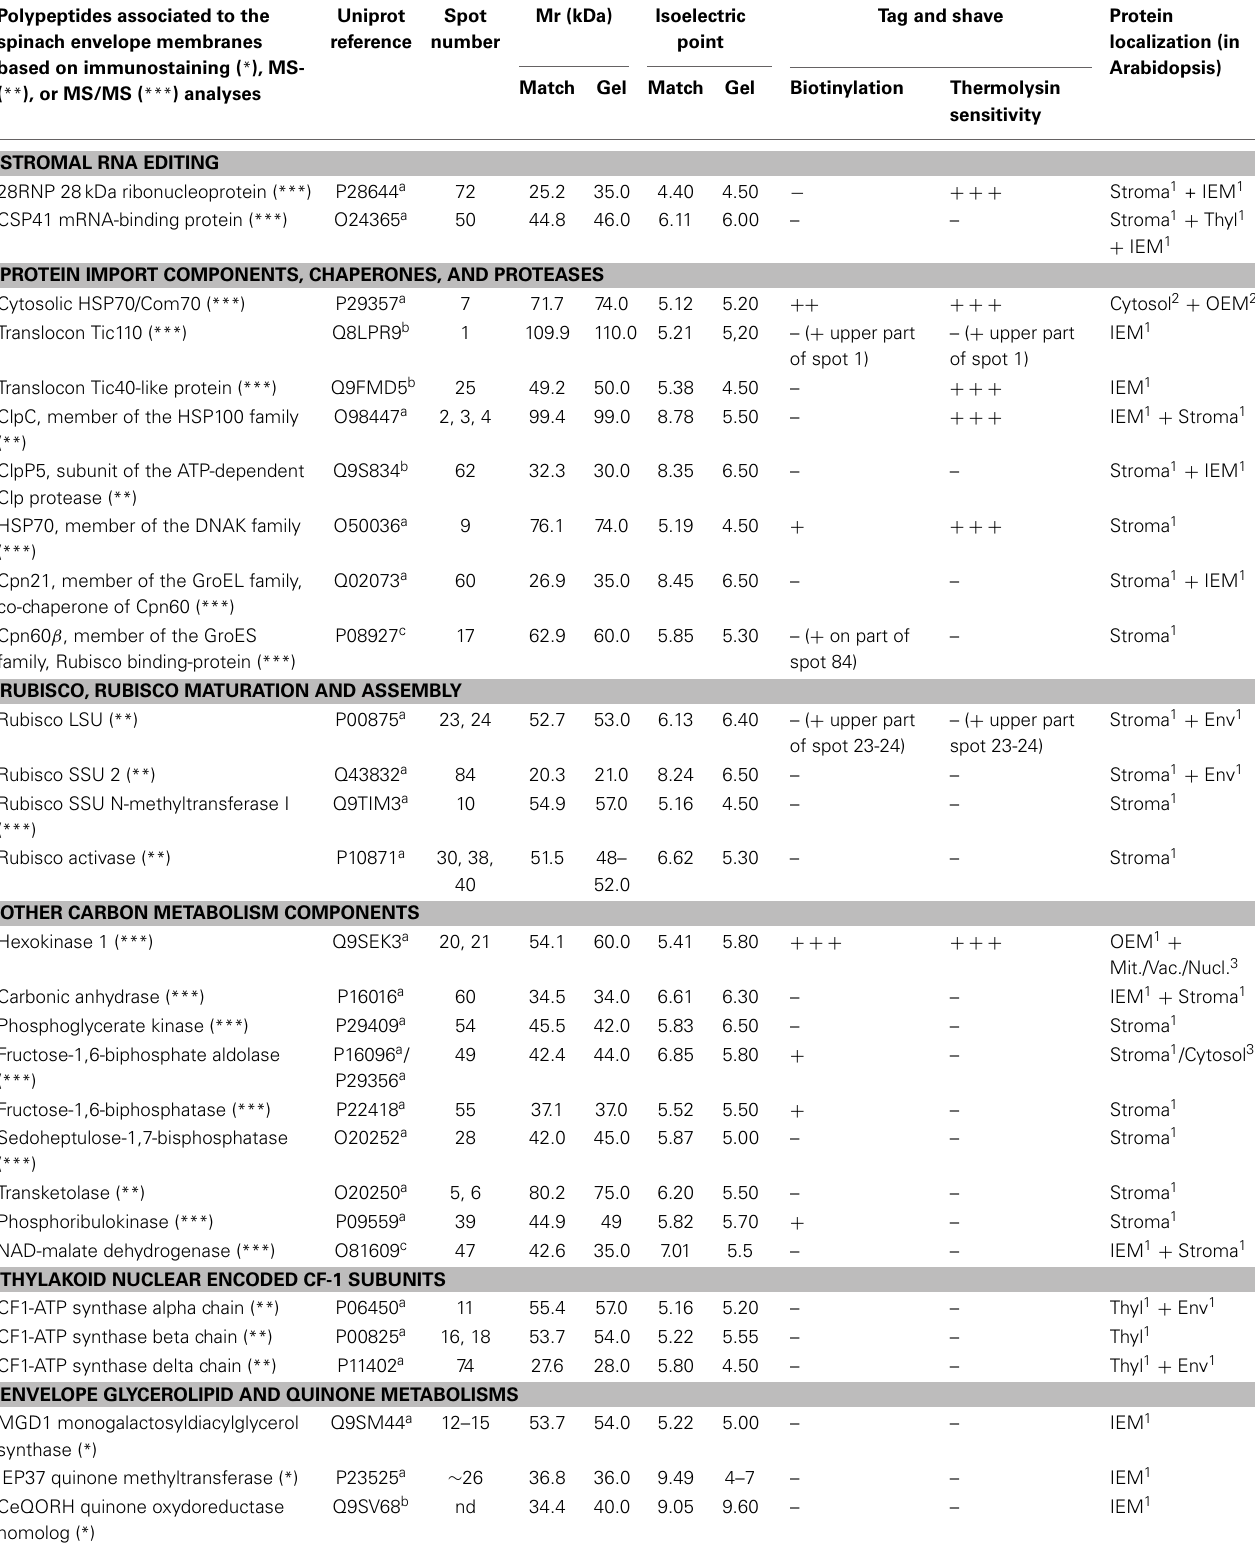
Table 2 | Preliminary analysis of a selection of chloroplast-associated polypeptides, following biotinylation or thermolysin treatment and 2D-PAGE